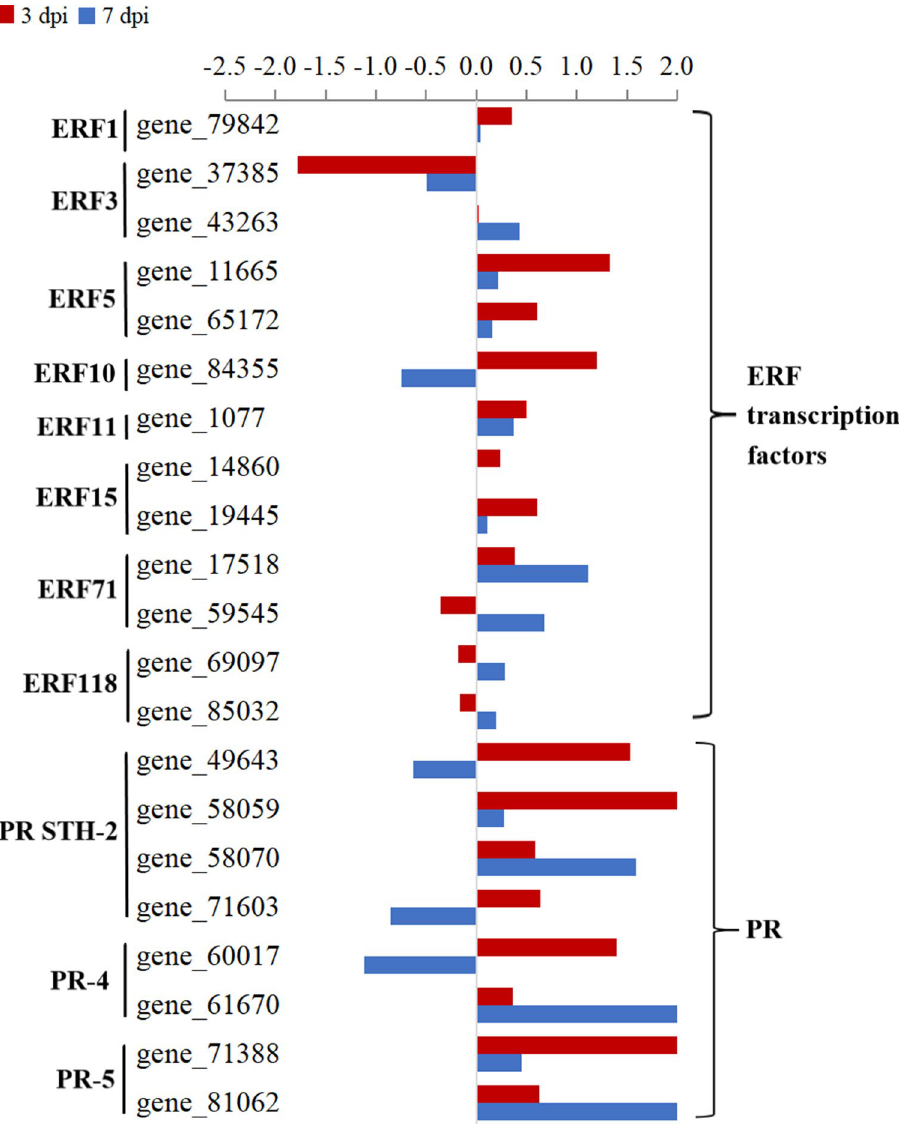
Figure 8. Comparison of the expression of genes associated with ERF transcription factors and pathogenesis- related proteins (PR) in resistant and susceptible cultivars in response to Ralstonia solanacearum infection. The bar represents log 2 (In-R/In-S), where In-R and In-S are read count values of the genes in resistant and susceptible cultivars induced by R.